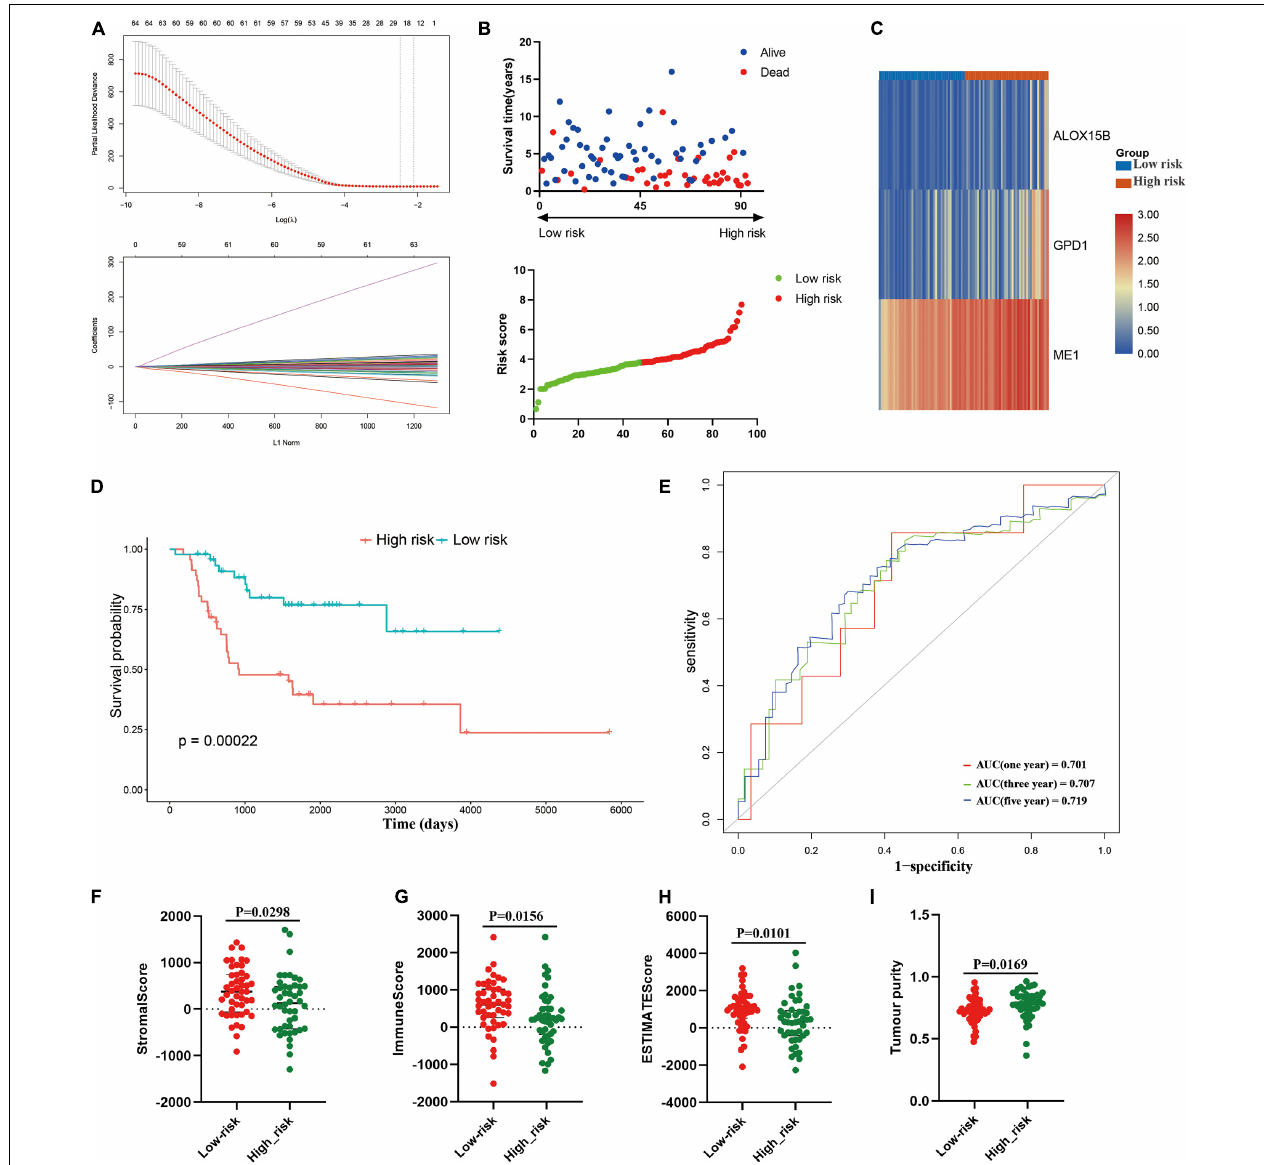
FIGURE 5 | Construction of risk model in the training cohort. (A) LASSO analysis with minimal lambda, (B) distribution of survival status and risk score of osteosarcoma patients in the high and low risk groups, (C) heatmap illustrating the expression of the three candidate genes in the two groups, (D) survival curve of the osteosarcoma patients in the two groups, (E) time-dependent ROC curve of the risk model, (F–I) stomal score, immune score, ESTIMATE score and tumor purity calculated by ESTIMATE